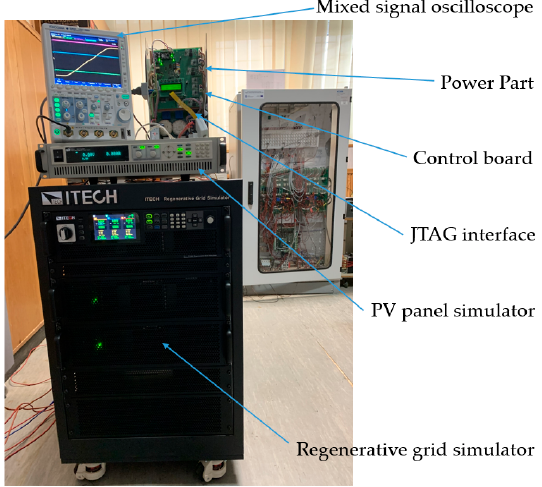
Figure 4. Photo of the test stand and the equipment used for the tests.